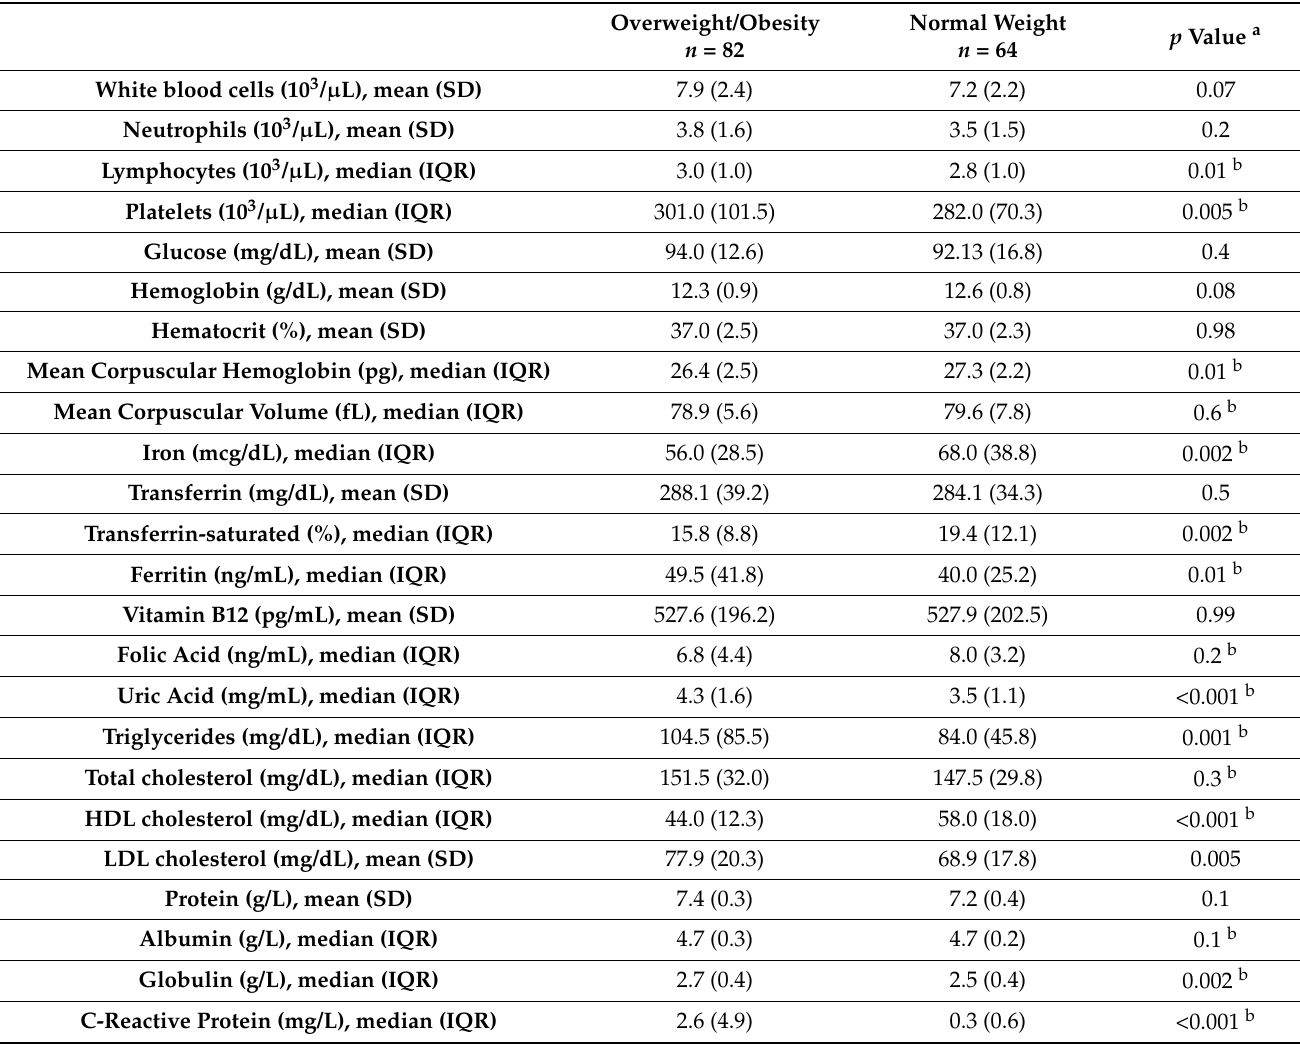
Table 2. Differences in the plasma/serum levels of nutritional and inflammatory markers between participants with normal and those with